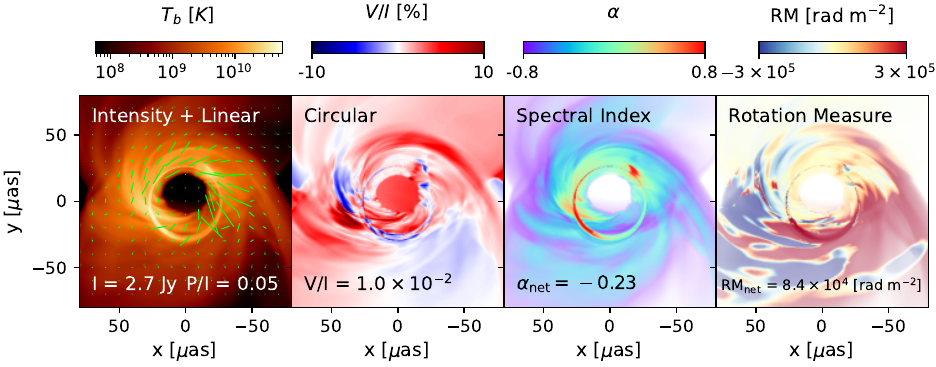
Figure 1. A single GRMHD snapshot ray-traced and scaled to Sgr A* properties, with three decades in dynamic range shown. In the leftmost panel, ticks representing the linear polarization have lengths scaled proportionally to the total linearly polarized intensity. To date, total intensity maps have been produced for both Sgr A* and M87*, a linear polarization map has been produced for M87*, and the remaining observables have yet to be generated for either source. In the era of ngEHT, we will have access to each of these observables with improved dynamic range and time-domain information, which will greatly inform models of the black hole accretion flow. Note that finite spatial resolution and other data corruptions have not been taken into